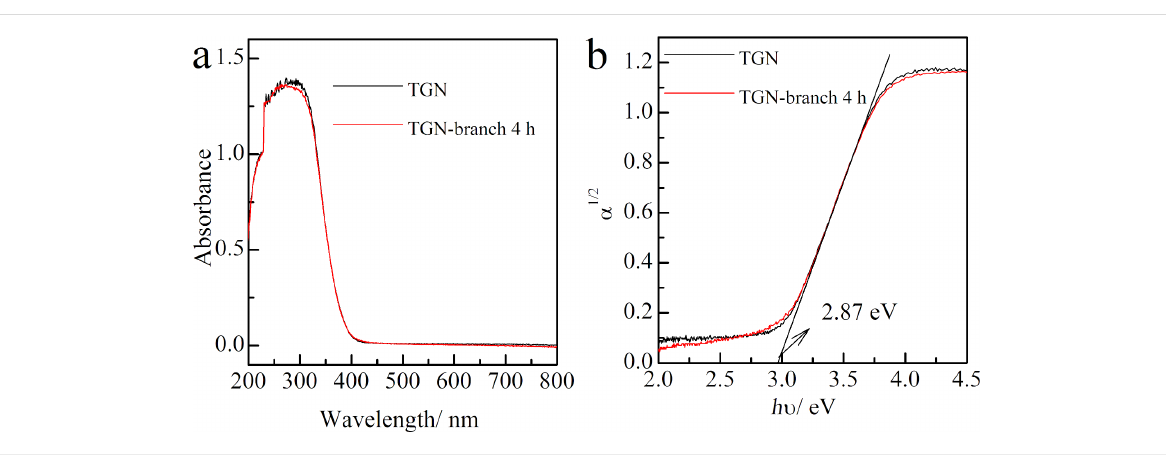
attributed to the same phase composition of TiO 2 (B) in both samples. The evaluated band gap of 2.87 eV for TiO 2 (B) agrees with that (2.9 eV) reported by Kandiel et al. [25]. This band gap value is smaller than that of 3.2 eV for bulk anatase TiO 2 [27]. the pure TiO 2 (B) is located at a relatively longer wavelength compared to that of the pure anatase TiO 2